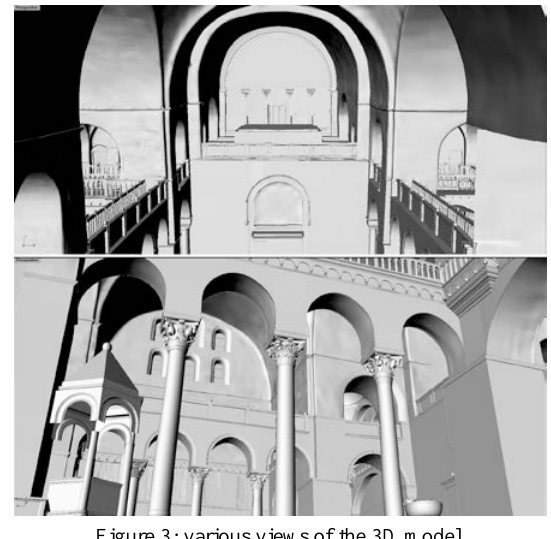
Figure 3: various views of the 3D